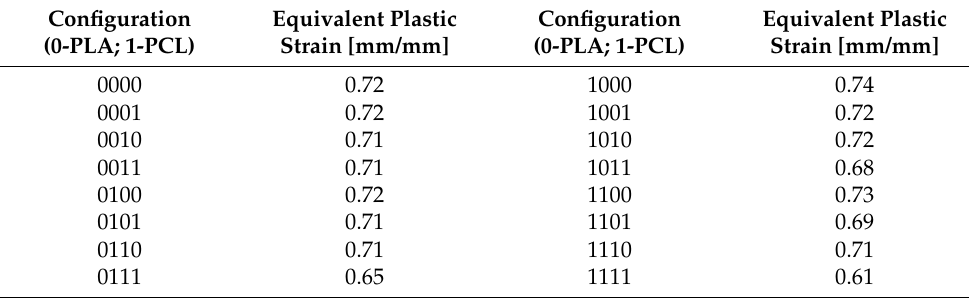
Table 4. Equivalent plastic strain after final analysis step for different material configurations.